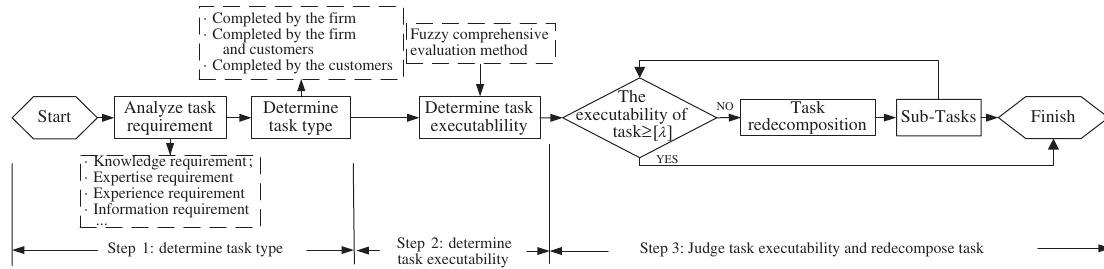
Figure 2: The Process of Task Executability Analysis.